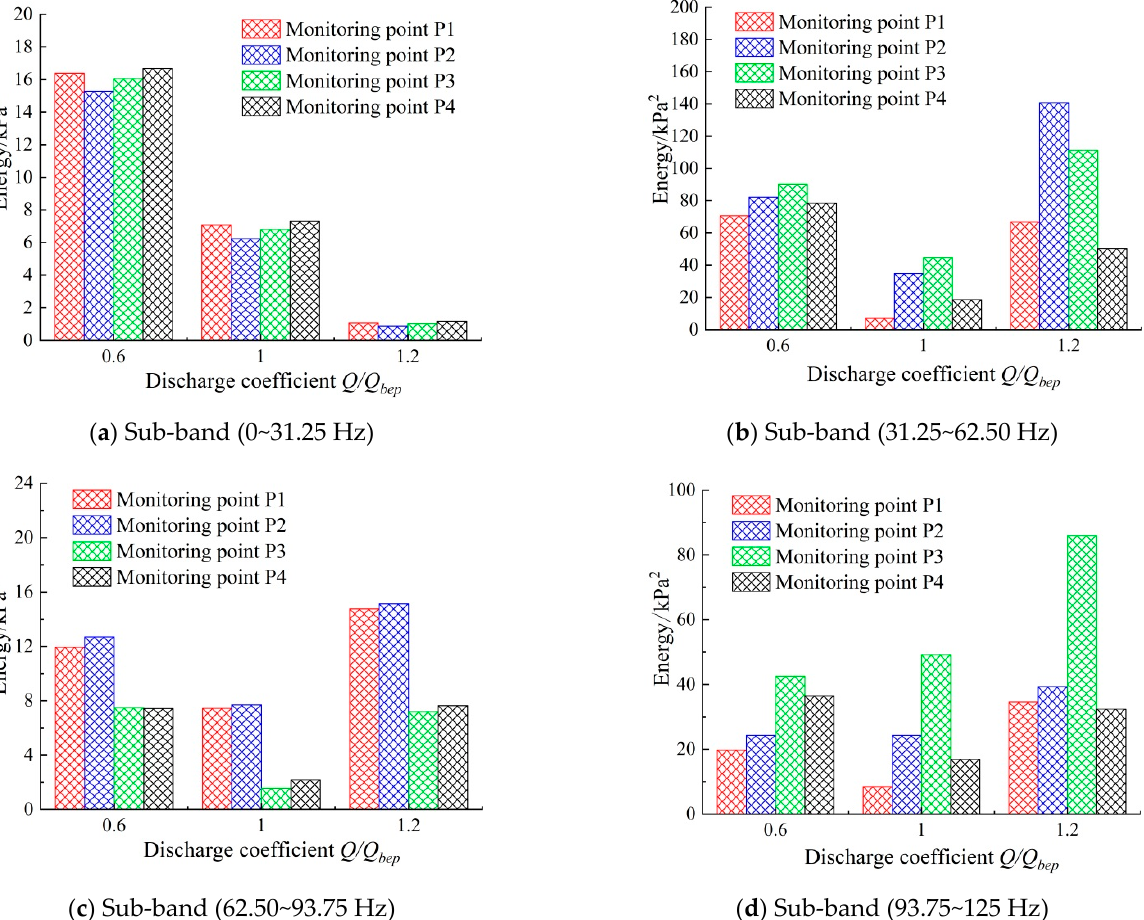
Figure 16. Energy value of each sub-band decomposed by wavelet packets at different monitoring points.